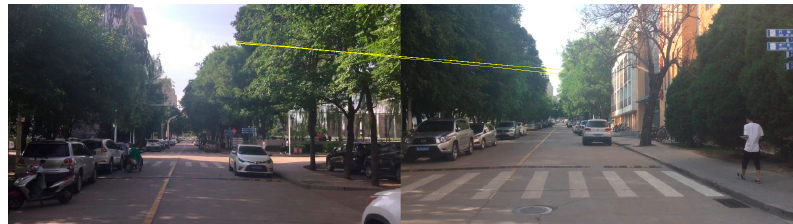
Figure 16. The number of the successfully matched feature points of these two images is only three, whereas the value of β ’ calculated by the scanline intensity algorithm is 0.0743.